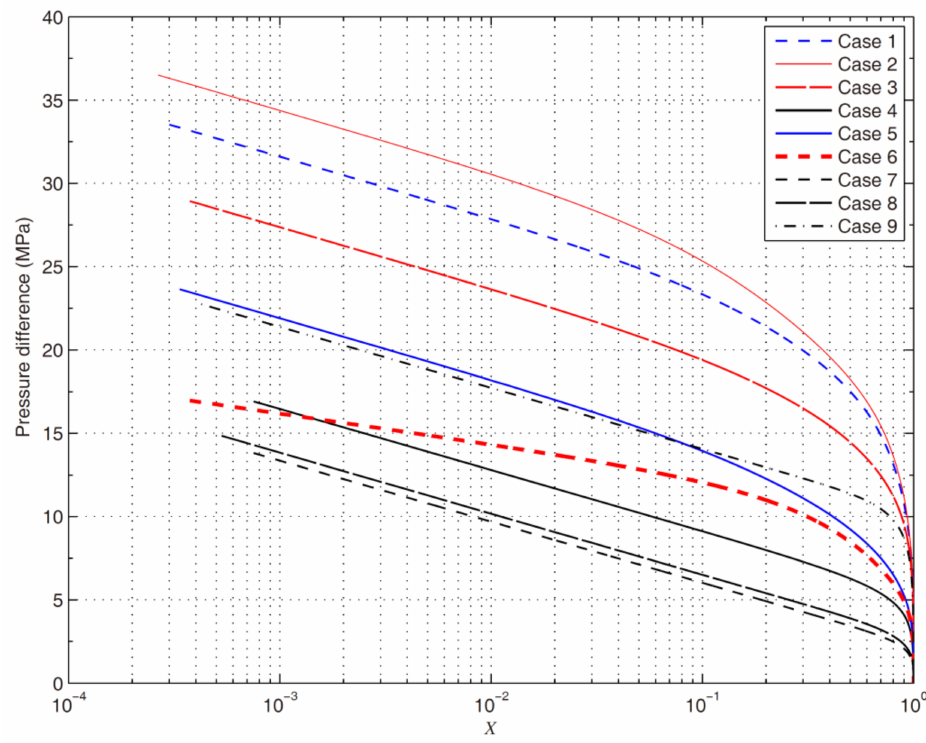
Figure 4. Predicted variations of pore pressure relative to the pressure on the production well wall versus the nondimensional X (distance from the injection well center scaled by the corresponding inter-well distance) for the nine